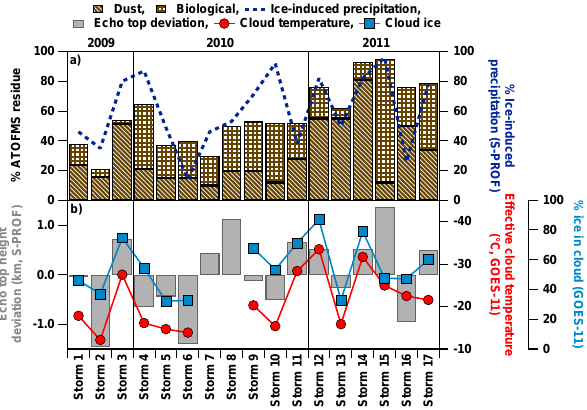
Figure 4. Summary of IN precipitation residue composition, ob- served surface meteorology at SPD, and cloud properties above SPD. (a) The percentages of dust and biological residues and the % ice-induced precipitation (snow plus BB rain). (b) Echo top height deviation (km) calculated from all storms during CalWater (aver- age: 3.51km based on data from 43 days during ATOFMS sam- ple collection time periods provided in Table 1). Positive (nega- tive) deviations correspond to higher (lower) than average echo top heights. Effective cloud temperature and percentage of cloud ice are also shown. Data were removed if in the homogeneous nucleation regime ( ≤− 36 ◦ C). The respective instruments in which each mea- surement was acquired is provided in the axis labels.